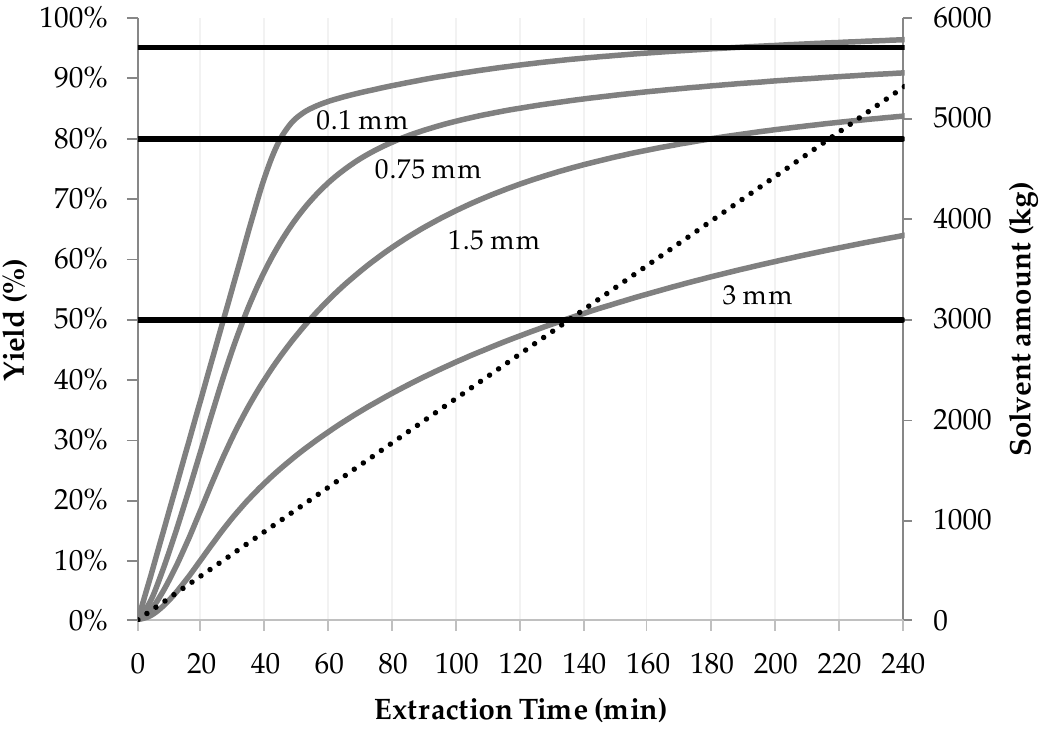
Figure 11. Yield and Solvent Consumption for hawthorn at different mean particle diameters [35].